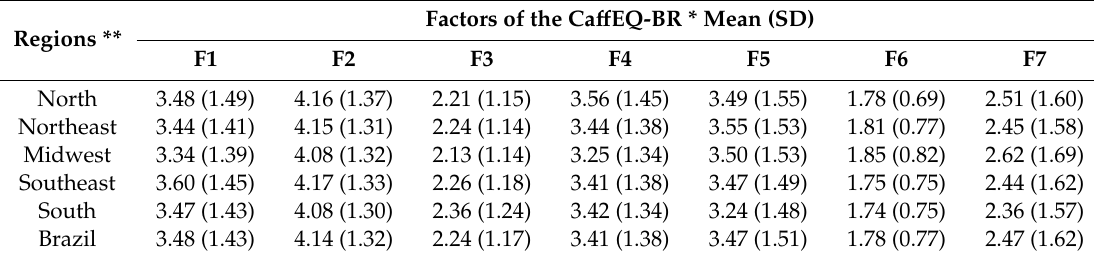
Table 5. Mean and Standard Deviation (SD) of the scores on a six-point Likert scale of the seven factors of the Ca ff eine Expectancy Questionnaire in Brazil (Ca ff EQ-BR) by regions of Brazil ( n = 4202). Factors of the Ca ff EQ-BR * Mean Regions **